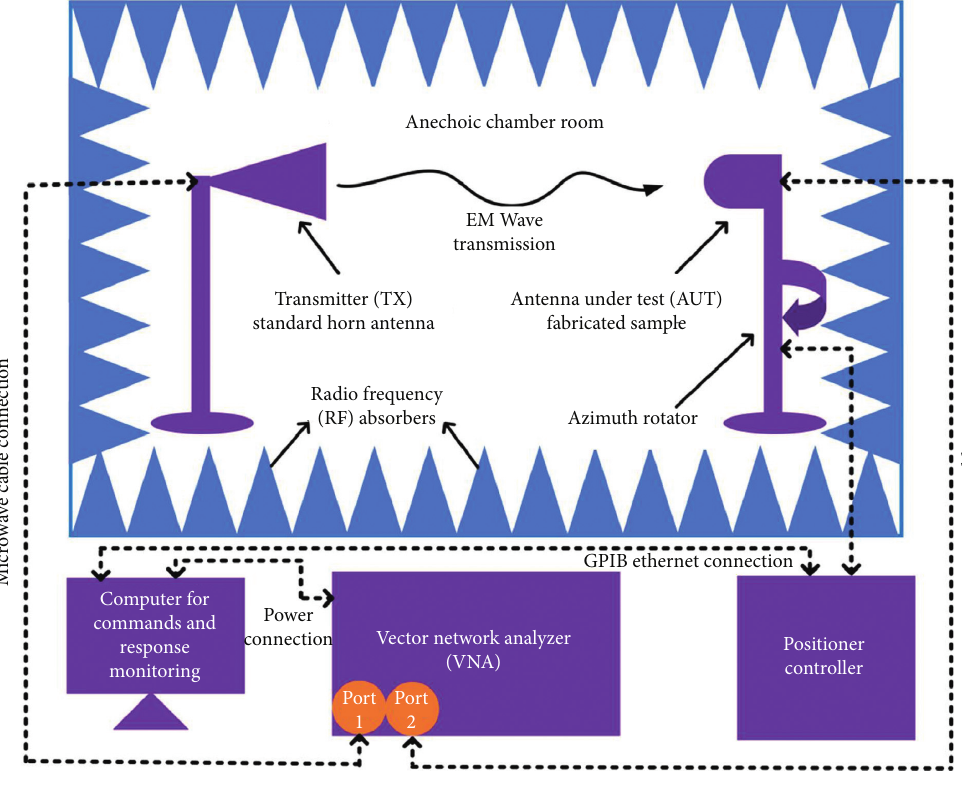
Figure 7: Graphical representation of overall measurement setup.